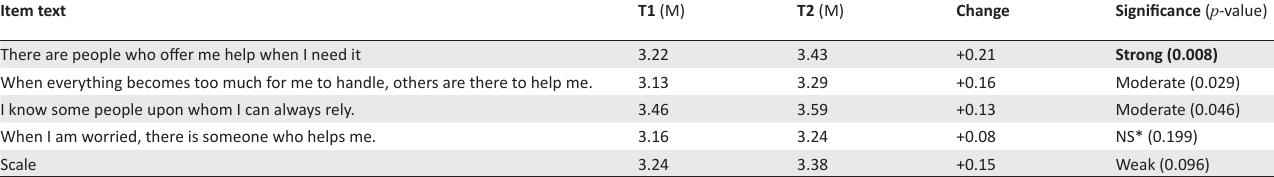
TABLE 7: Results for the Berlin Social Support Scale (instrumental perceived available support): Item-level statistics. Item